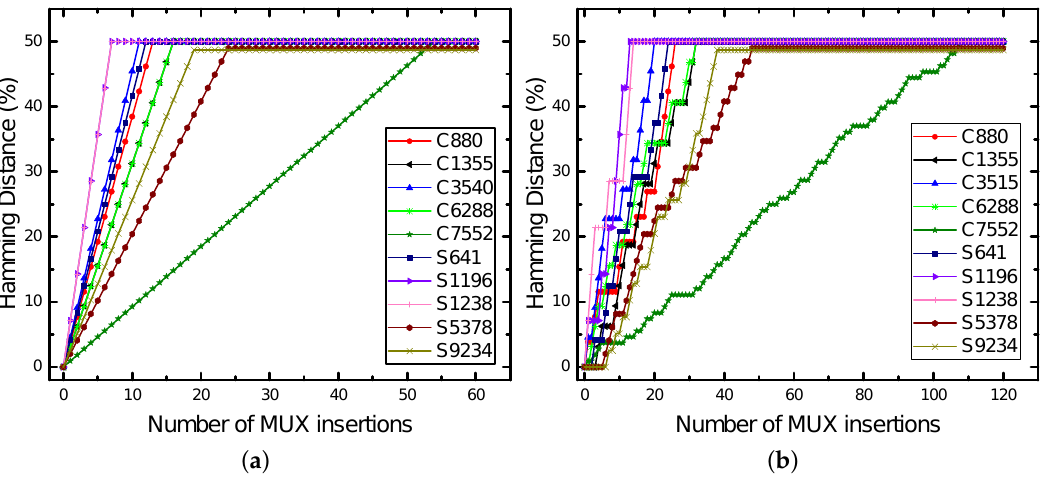
Figure 6. ( a ) MUX insertions based on the half output number for different ISCAS-85 and ISCAS-89 benchmark circuits. ( b ) MUX insertions based on the full output number for different ISCAS-85 and ISCAS-89 benchmark